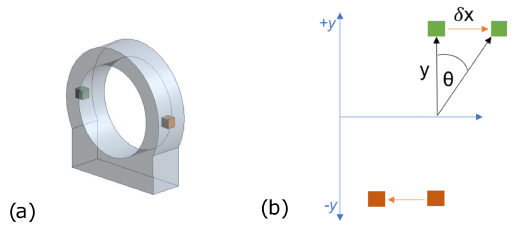
Figure 15. Node selection within the bearing housing for estimat- ing torsional-spring stiffness in the horizontal